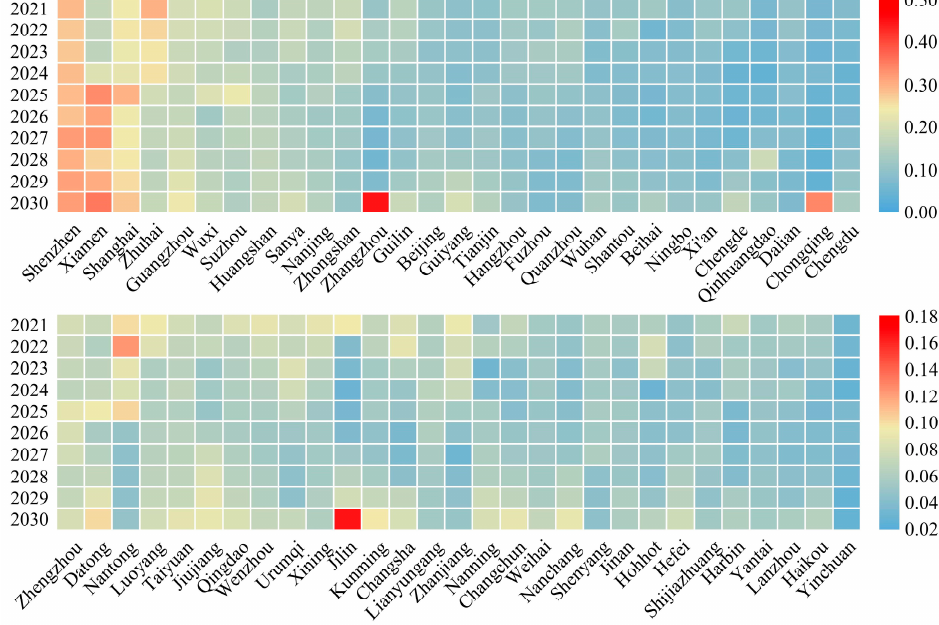
Figure 8. Predicted index of TEV in 2021–2030.